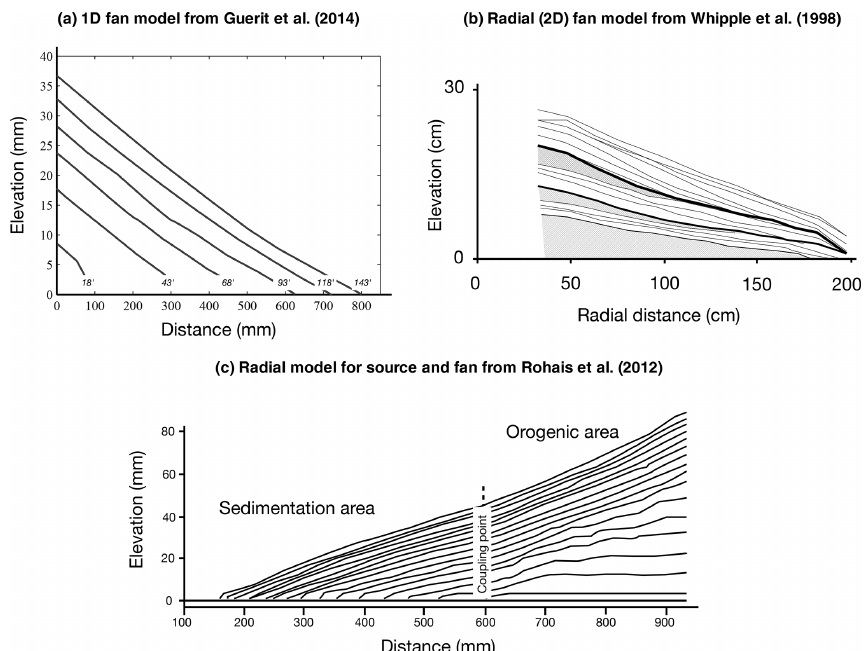
Figure 15. Stratigraphy observed in three laboratory experiments displaying a behavior similar to that predicted by (a, c) the TL model (from Guerit et al., 2014; Rhohais et al., 2012) and (b) the ξ – q model (from Whipple et al., 1998). Note that none of these experiments included rainfall in the fan area. Panel (a) is reproduced from Guerit et al. (2014), (b) is from Whipple et al. (1998) and (c) is from Rhohais et al. (2012).